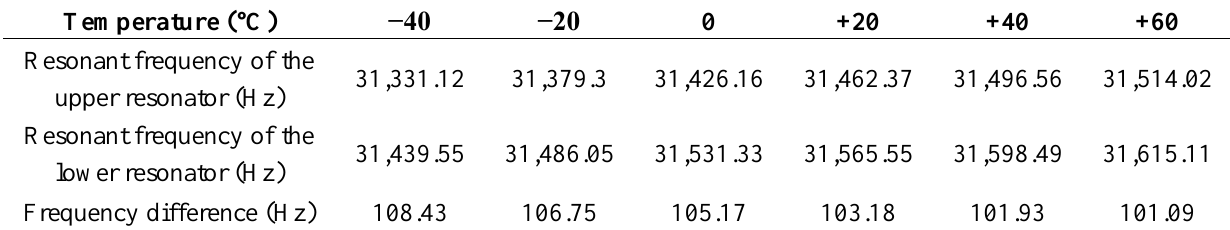
Table 7. The full temperature test result of the improved accelerometer.